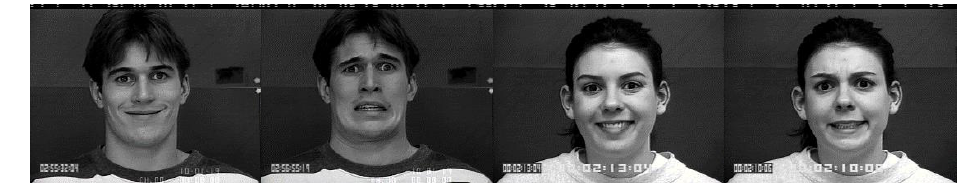
Figure 9. Happy and fear expression examples.